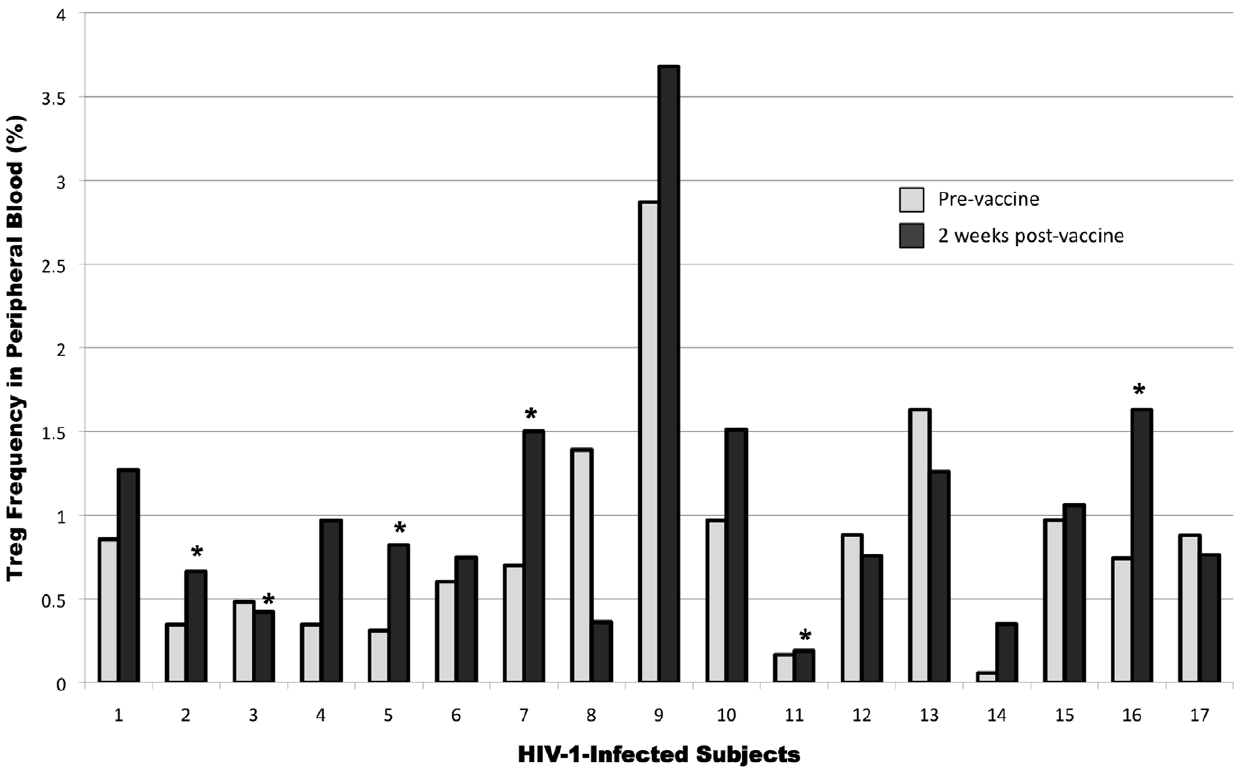
Figure 4. Treg frequency in paired pre- and post-vaccine of the 17 subjects. Percentages of CD4 + CD25 HI FOXP3 + T cells before (pre-vaccine) and 2 weeks after therapeutic vaccination in each of the 17 HIV-1-infected subjects are shown. Asterisks indicate subjects who had a positive vaccine response by ELISPOT analyses. There was a trend of increased Treg frequency post-vaccine. (P=0.06)